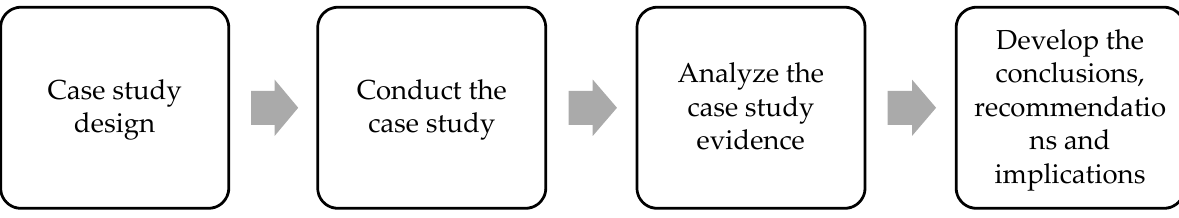
Figure 7. Adapted case study design chart.